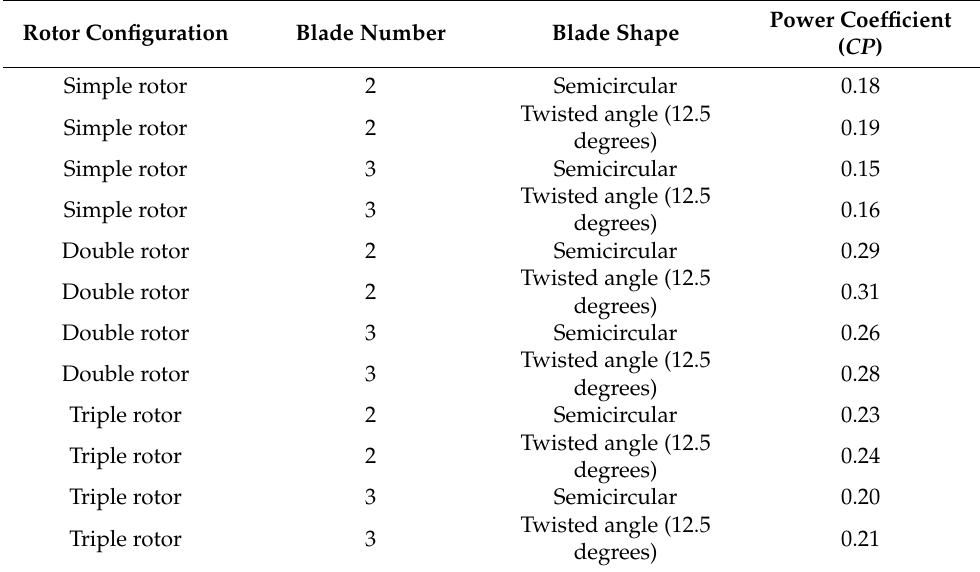
Figure 5. Classical two-bladed SAVONIUS rotor in different configurations: ( a ) simple rotor; ( b ) double rotor; ( c ) triple rotor. The obtained results are presented in Table 3 for each analyzed case. Table 3. Power coefficient results for different rotor configurations